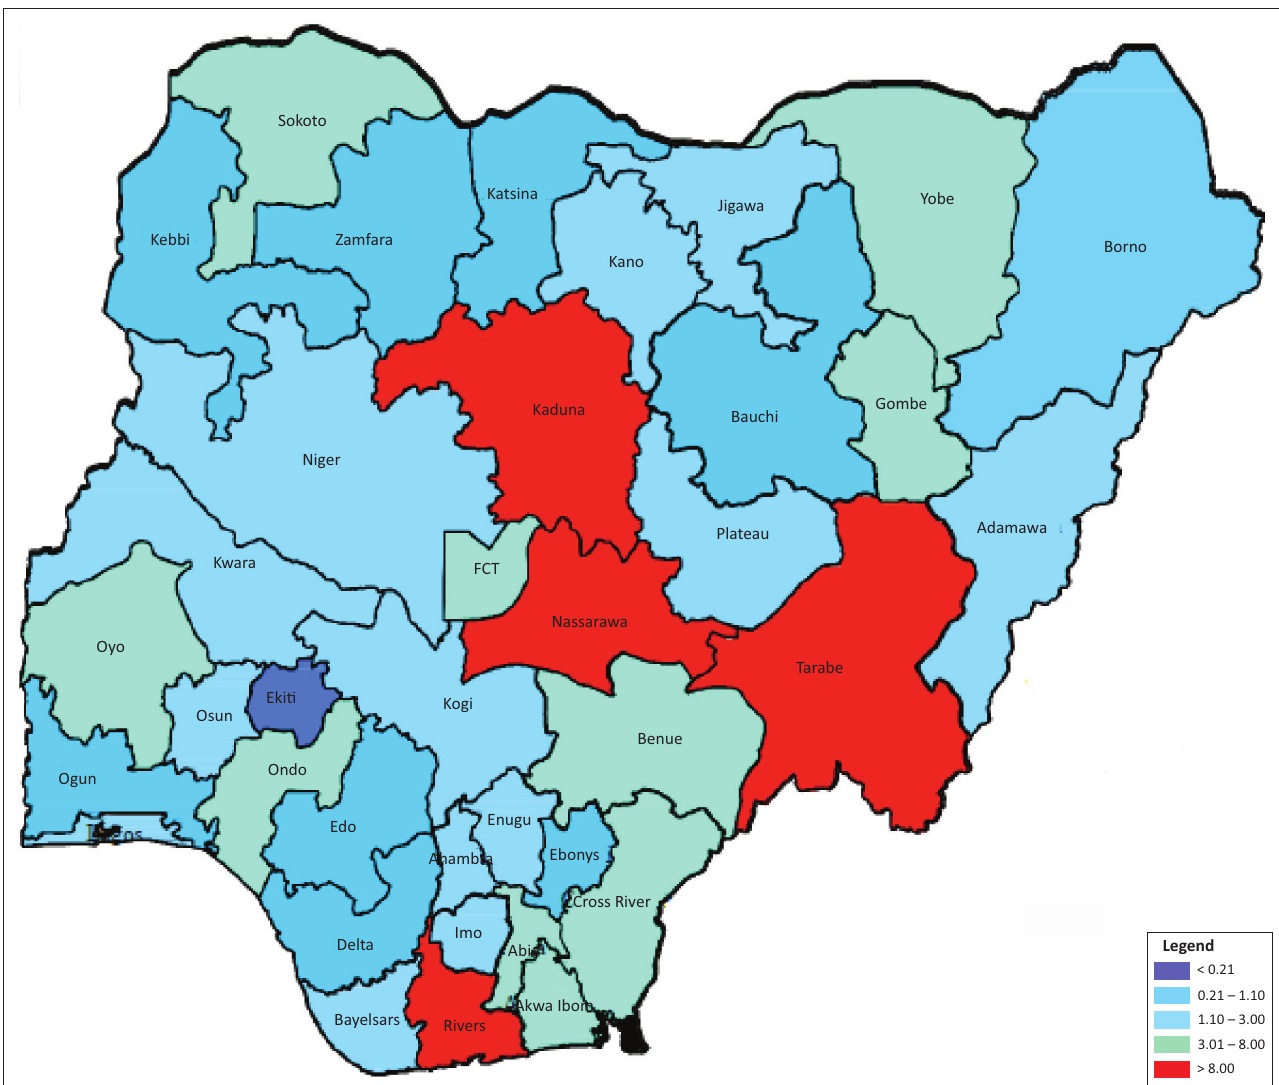
FIGURE 1: HIV prevalence in Nigeria by